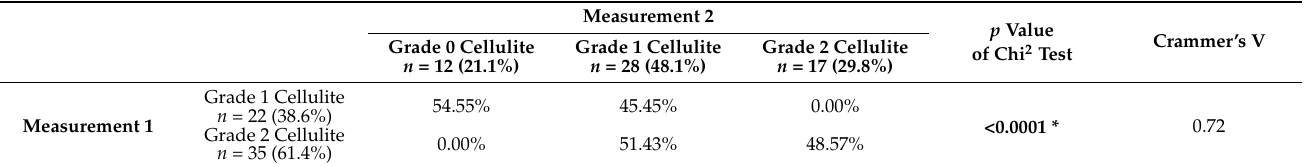
p Value of Chi 2 Test Grade 1 Cellulite